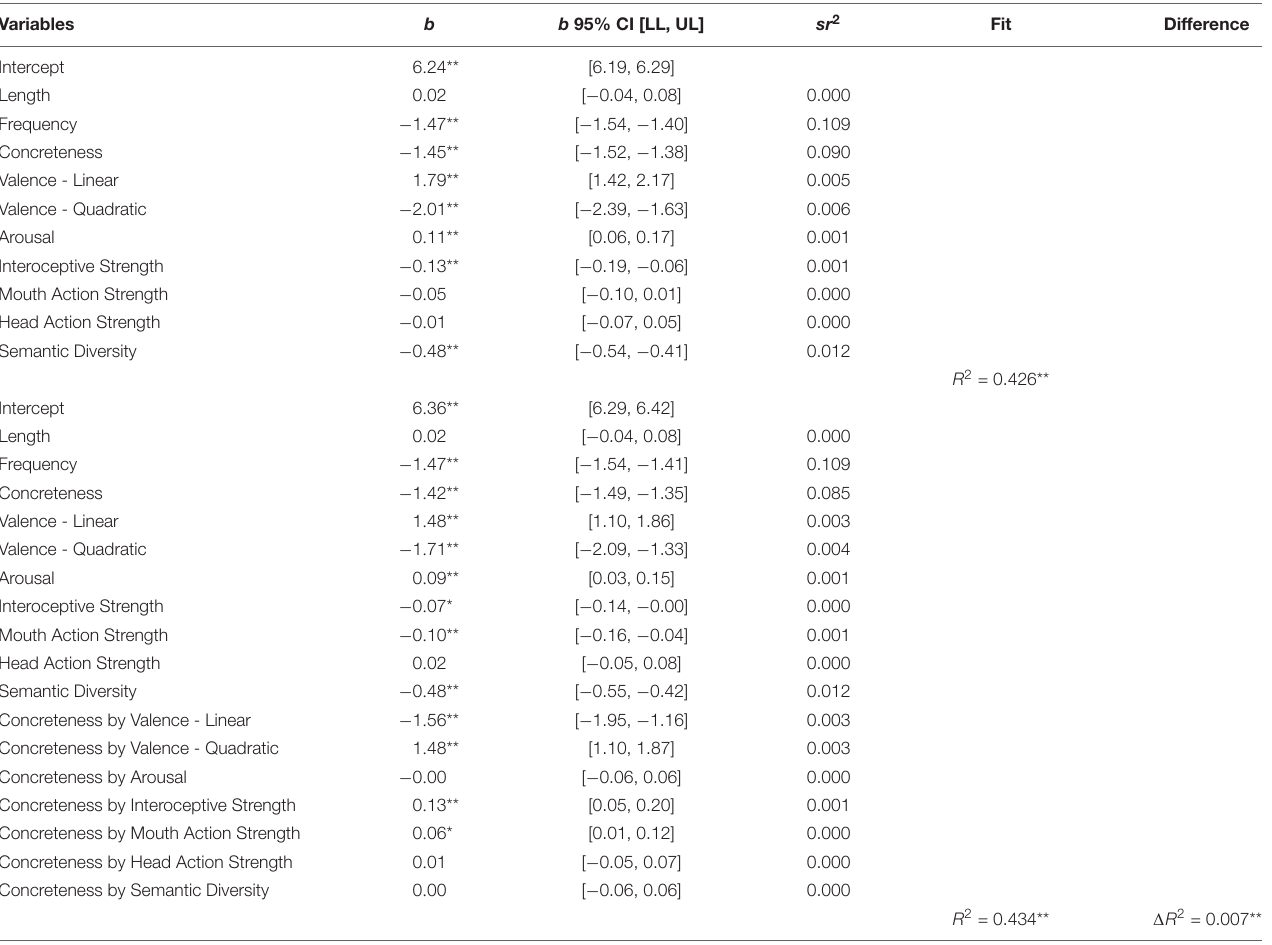
TABLE 2 | Hierarchical regression predicting test-based AoA using all variables of interest ( N =